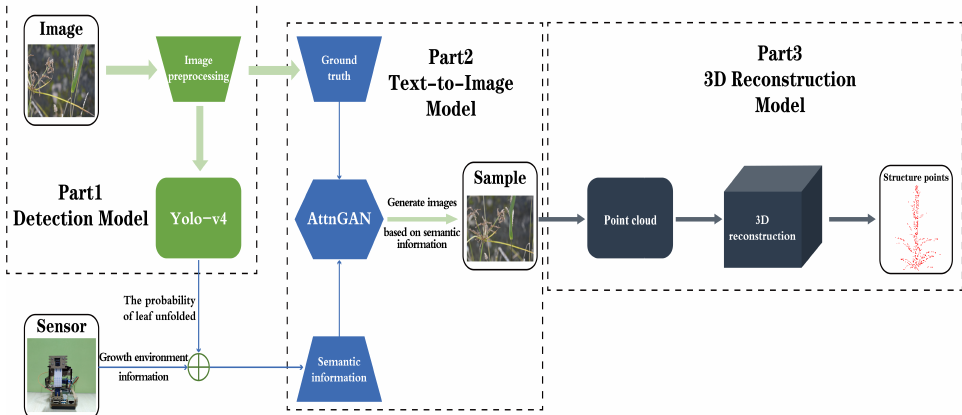
Figure 1. The architecture of our work. Part 1 is the detection model; the model can detect whether the wheat leaves are unfolded or not, and the probability of leaf unfolded and the information of growth environment are composed of semantic information for the next stage. Part 2 uses semantic information and real images to train a generator that can transform semantic information to images. Part 3 uses the image generated in Part 2 to reconstruct the 3D point cloud model of